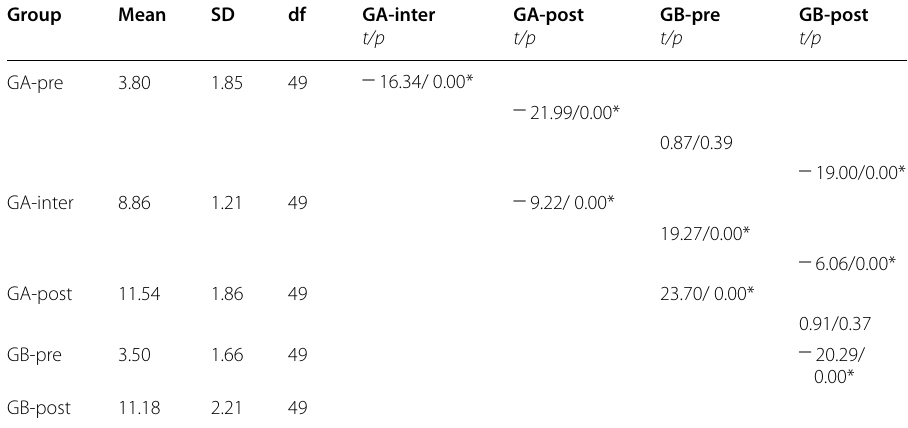
Table 3 t-test result of pre-CUQ, intermediate-CUQ and post-CUQ assessment of Group A and Group